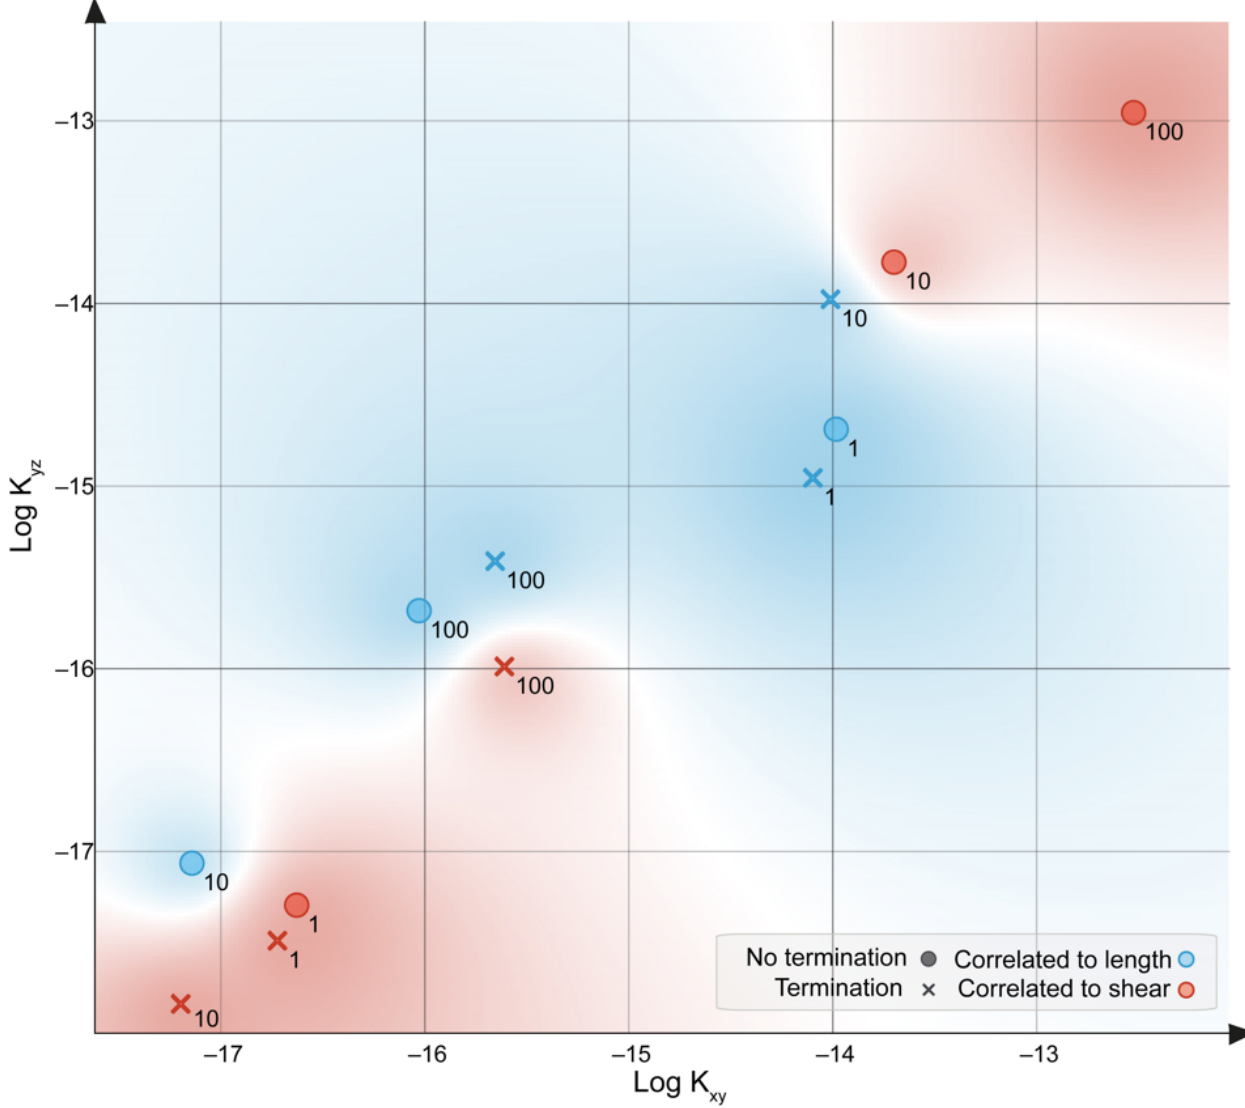
Figure 11. K xy versus K yz cross plot showing heterogeneities of permeability tensor term implied by the shear dependency of fracture aperture and fracture termination parametrisation, values from case 1 (LD).